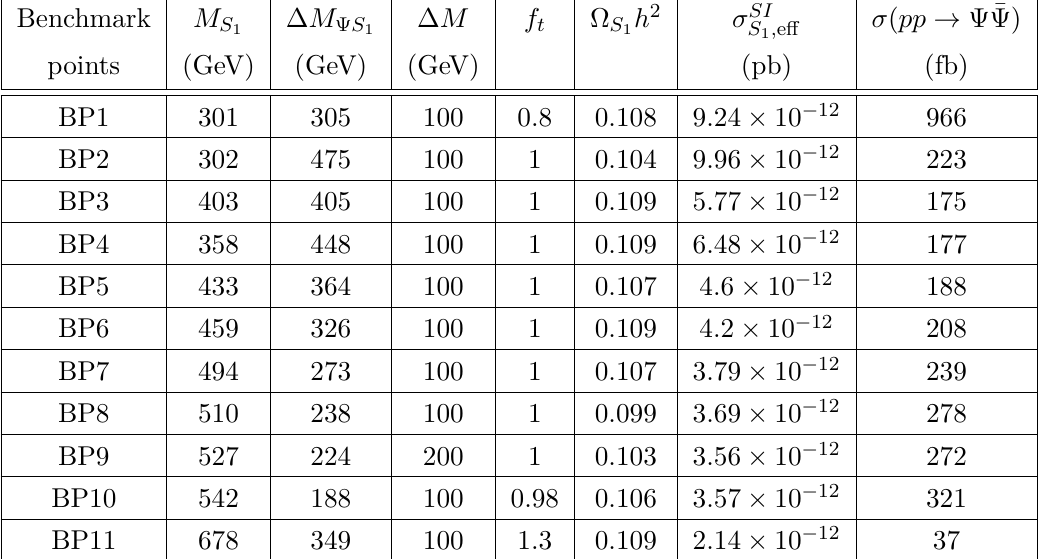
Table 2. Different benchmark points satisfy the observed relic density of DM, direct and indirect detection (not shown in the table) bounds, along with the constraints coming from the theoretical and LHC data, as listed in the text. M is the mass of the DM, S . f is the coupling strength of S 1 1 t the interaction between top quark, VLQ, and the scalar S (see: eq. (2.1)). ∆ M = M Ψ S 1 Ψ − M S 1 and ∆ M = M . Ω (see: eq. (4.8)) are the relic density 2 (see: eq. (4.7)) and σ SI S 2 − M S 1 S 1 h S 1 , eff of DM, S and effective direct detection cross-section, respectively. Other parameters are F = 1 a 10 11 GeV , λ = 0 . 01 , and f = f = 0 . 01 . The production cross-section of the partonic process SH u c Ψ¯Ψ at LO for different benchmark points before decaying into SM quark and scalar at 14 TeV pp → LHC is given at the last